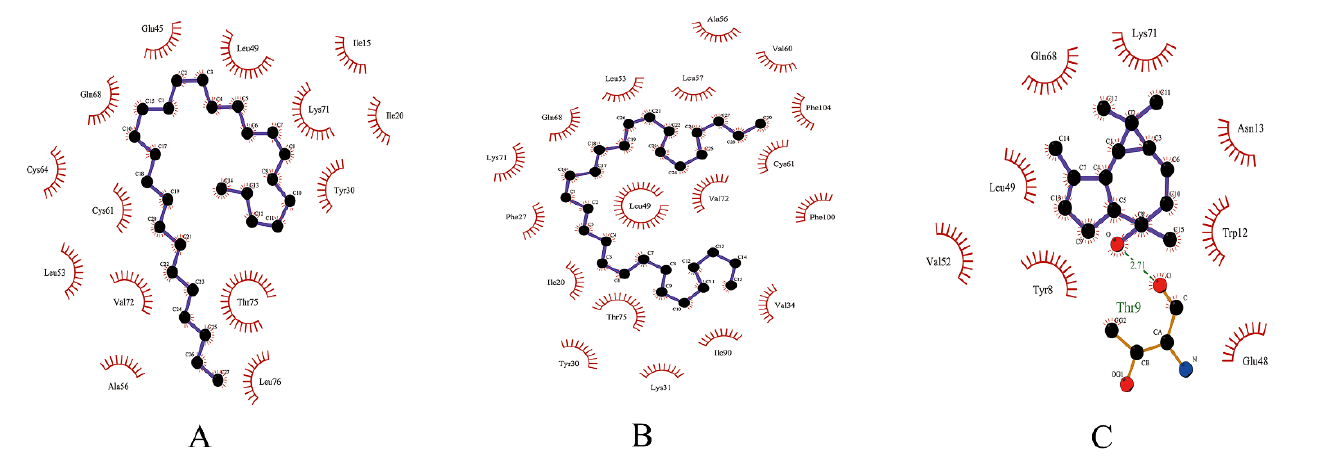
Figure 7. Interactions in protein-ligand binding complexes. (A) SnitCSP4-(Z)-7-heptacosene, (B) SnitCSP4-(Z)-9-nonacosene, (C) SnitCSP4-(-)-globulol complexes.